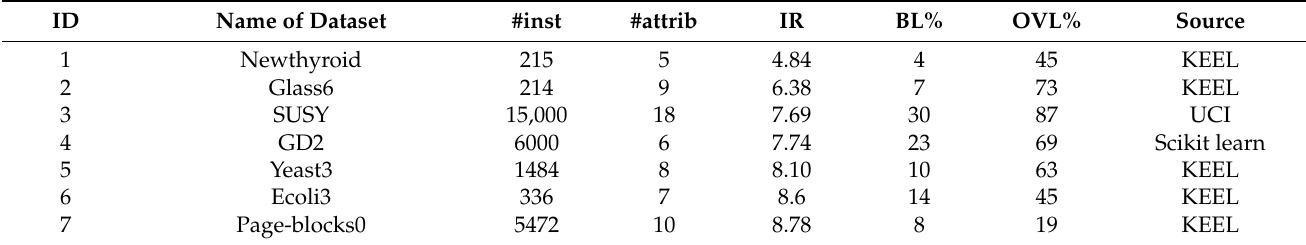
Table 1. Information about the datasets used in the